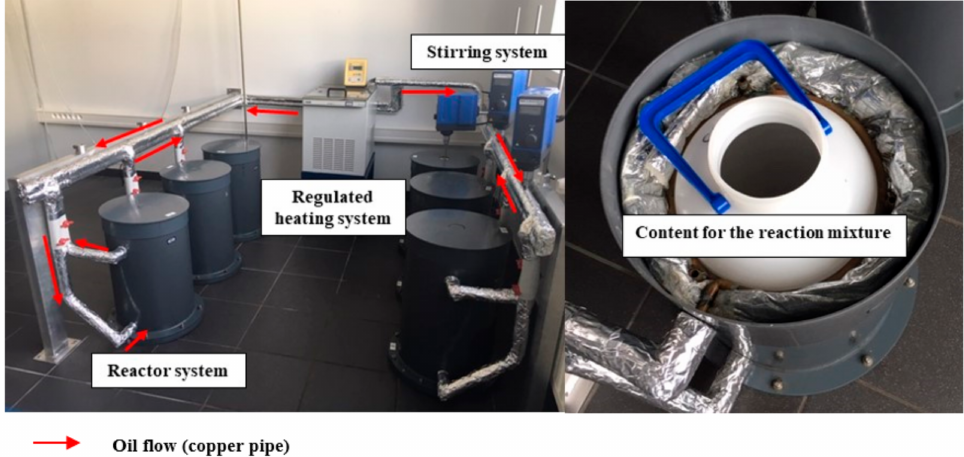
Figure A7. Large scale synthesis